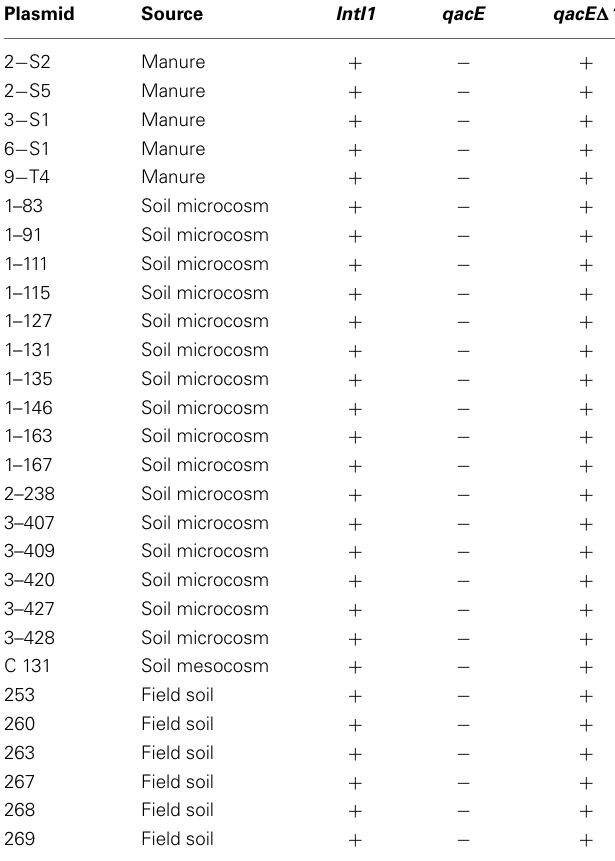
Table 2 | IncP-1 ε plasmids captured by exogenous plasmid isolation from different environments (Heuer et al., 2012) tested for the presence of class 1 integron integrase genes ( intI1 ) and quaternary ammonium compound resistance genes qacE and qacE (cid:2) 1 by PCR and subsequent Southern blot